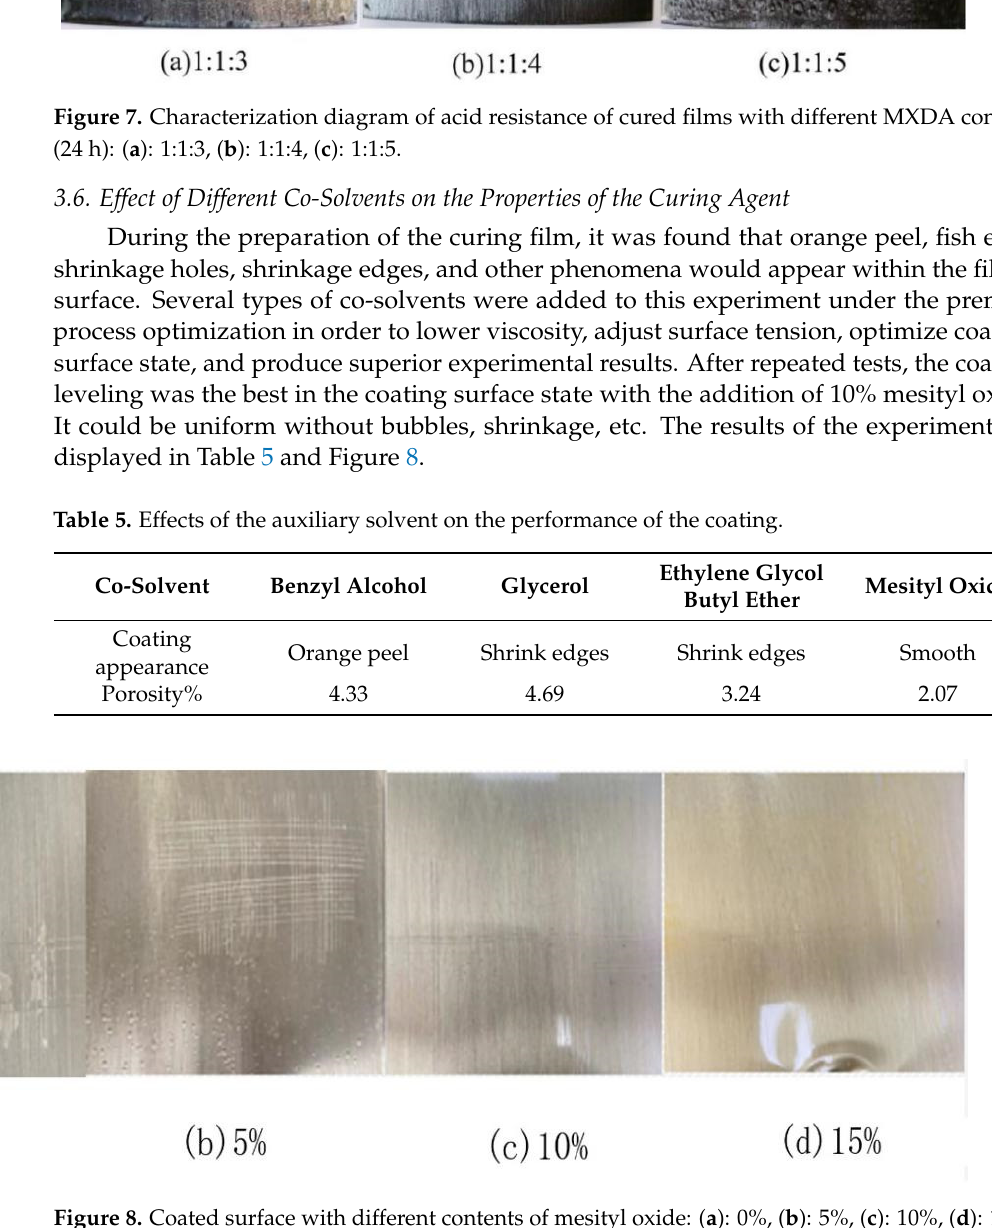
15%. When no co-solvent was added, there were some small resin particles in the emulsion,